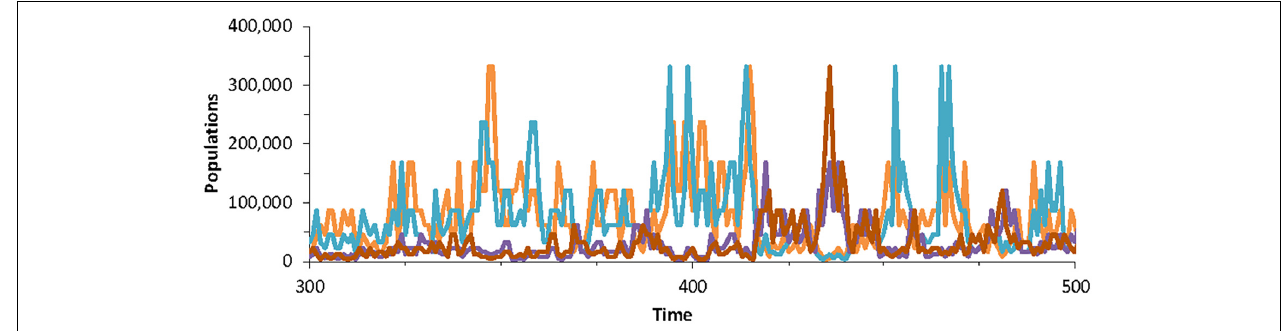
FIGURE 3 | Population dynamics of four randomly chosen species in the community model generated using Special case B, with parameters K = 7, with J = 5 × 10 6 for 200 time-steps. The dynamics are according to Equation (10) and thus do not include extinction-colonization.